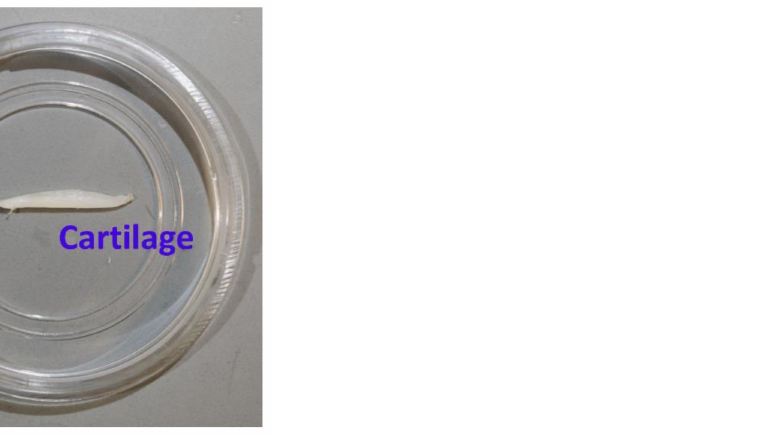
Figure 1. Articular cartilage sample used in the experiments for acoustic imaging for both the in-house fabricated and the commercial PVDF